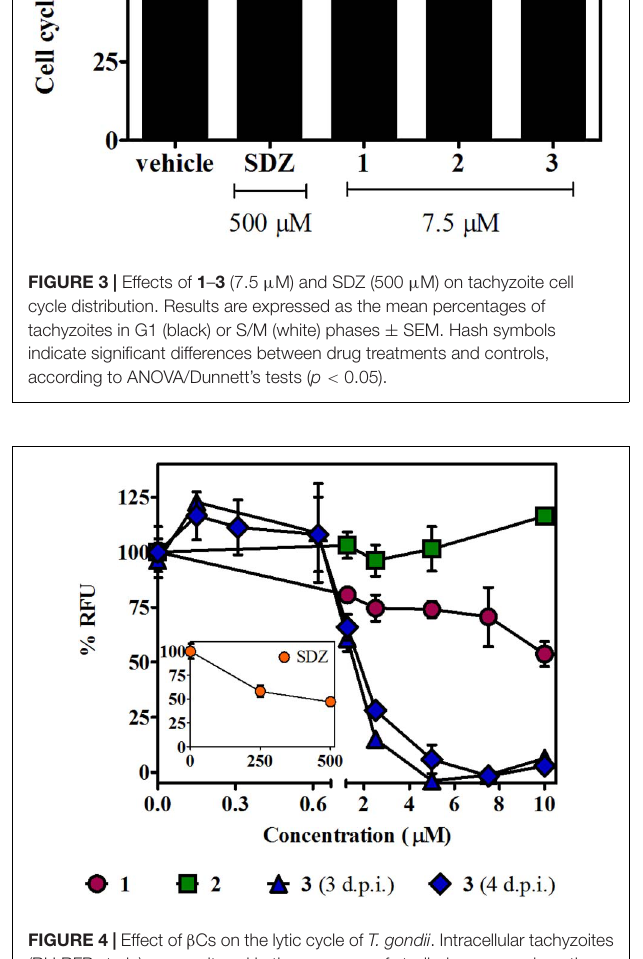
FIGURE 4 | Effect of β Cs on the lytic cycle of T. gondii . Intracellular tachyzoites (RH RFP strain) were cultured in the presence of studied compounds or the vehicle. Results are means of % RFU (normalized to negative controls) ± SEM obtained after 3 or 4 days of treatment with several concentrations of 1 – 3 . The graph includes results from two independent experiments made in triplicates. Inset: Effect of SDZ (positive control) at the same